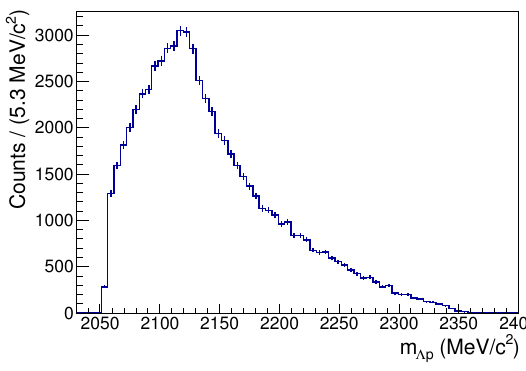
Figure 1. The Λ p invariant mass spectrum for the selected data